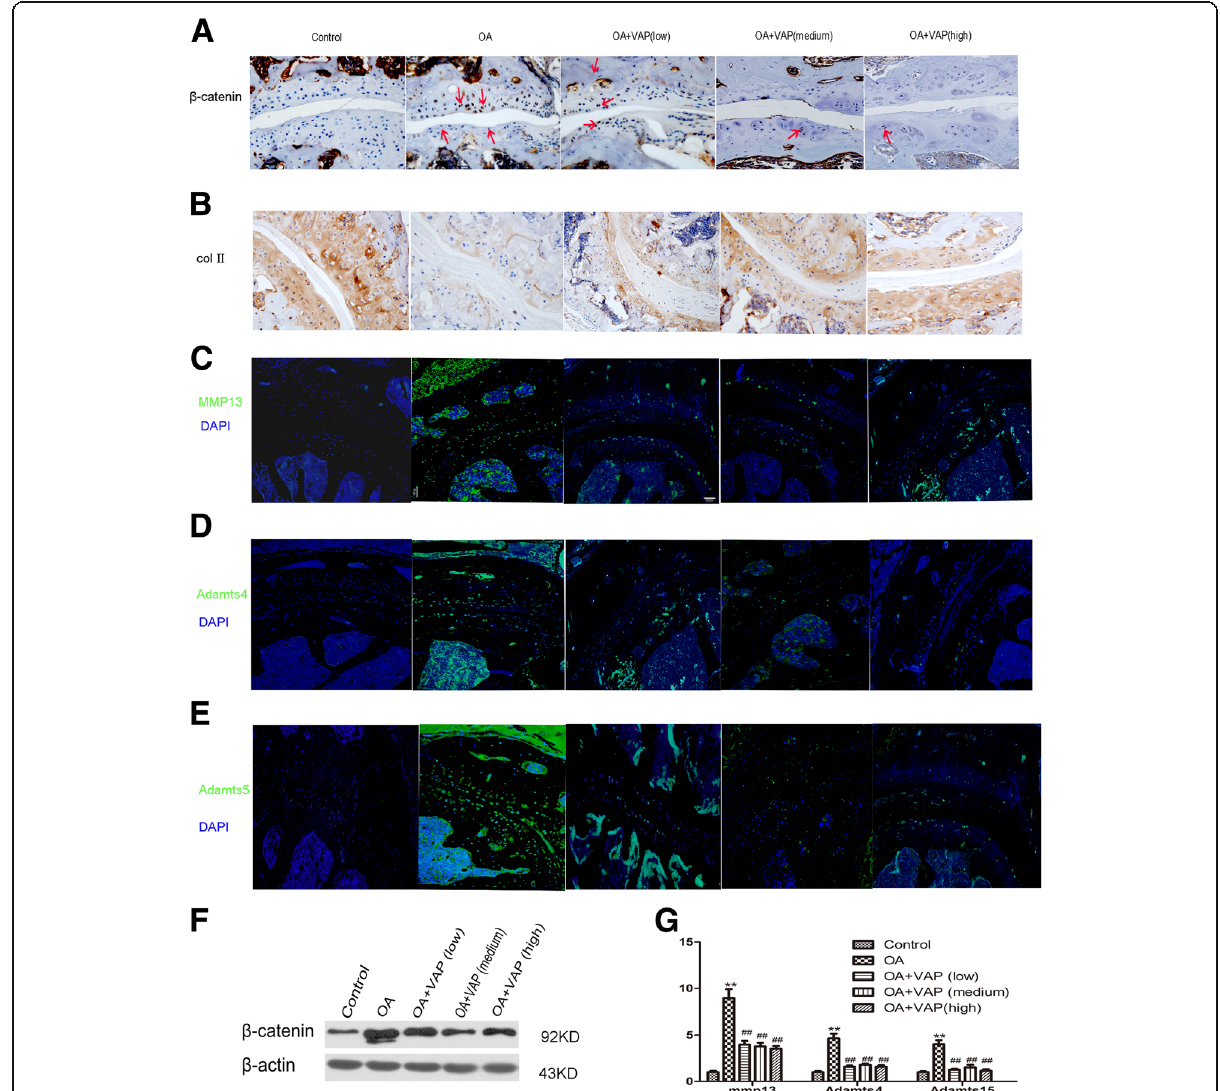
Fig. 2 VAP modulate ECM synthesis by inhibits MMP13, ADAMTS4 and ADAMTS5 via Wnt / β -catenin signaling pathway. Immunohistochemistry of β -catenin ( a ) and collagen II ( b ) were staining in mice facet joint disc. β -catenin was express in chondrcyte (dark brown) and collagen II immunoreactivity were evident throughout the entire cartilage matrix (light brown). IHC analysis showed that VAP regulate the expression of β - catenin and collagen II protein level in facet joint. IF showed MMP13 ( c ), Admts4 ( d ) and Admts5 ( e ) protein levels were significantly increased in OA model group compare with control group. In VAP groups, MMP13, Admts4 and Admts5 protein levels were reduced. VAP regulate the gene expression encoding for ECM degradation in facet joint. Lumbar disc tissues were harvest to proceed wstern blot analysis ( n = 5), the result indicate that compared with the WT group, protein level of β -catenin rise apparently in model group. Compared with model group, protein level of β -catenin declined in VAP different dosage group. VAP may partially downregulate the expression of β -catenin protein level ( f ). The mRNA expression of ECM degradation enzymes MMP13, ADAMTS4 and ADAMTS5 was evaluated by real-time polymerase chain reaction ( n = 5). Values were expressed as mean ± SD. * P < 0.05,** P < 0.01 vs Control group; # P < 0.05, ## P < 0.01 vs OA group ( g